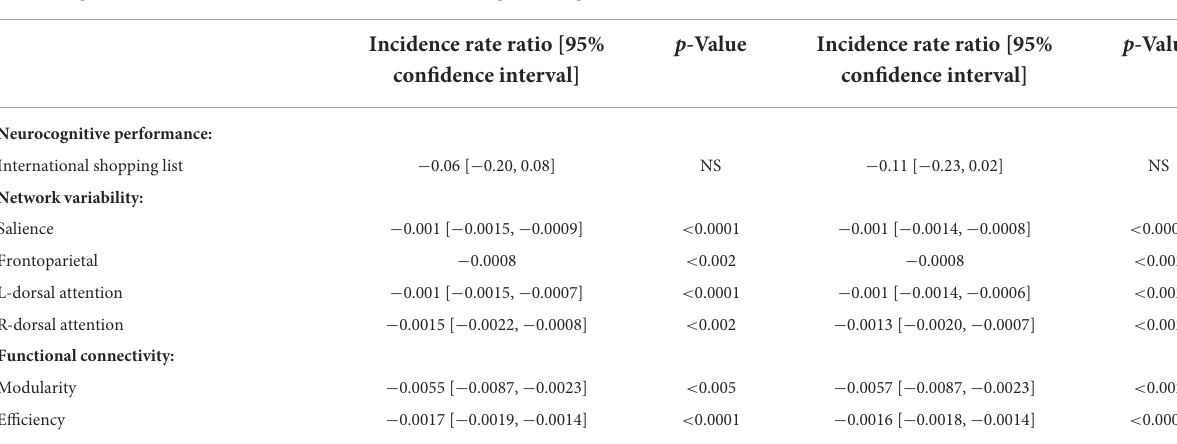
TABLE 2 Multivariate analysis of risks factors for neurocognitive decline after RT. Neurocognitive outcome metric a Age during RT Time since RT p -Value Incidence rate ratio [95% p -Value Incidence rate ratio [95% confidence interval] confidence interval]